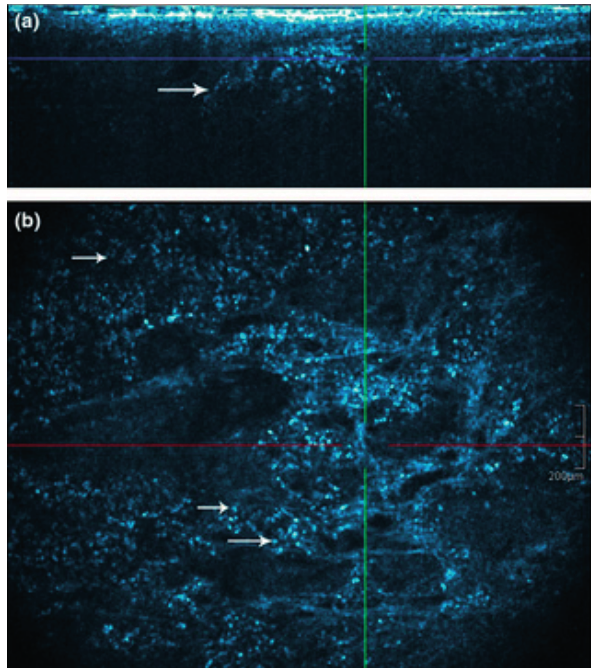
Figure 3. High-definition optical coherence tomography image of lip treated with permanent make-up. Aggregated pigmentation and formation of granuloma-like structures (white arrow) was identified below the epidermis from a cross-sectional image ( a ). Scattered pigment consisting of bright structures with dark centre that corresponded to pigment loaded macrophage (white arrow) was observed from en face high-definition optical coherence tomography (HD-OCT) image ( b ). Reproduced with permission from [18], published by European Academy of Dermatology and Venereology,